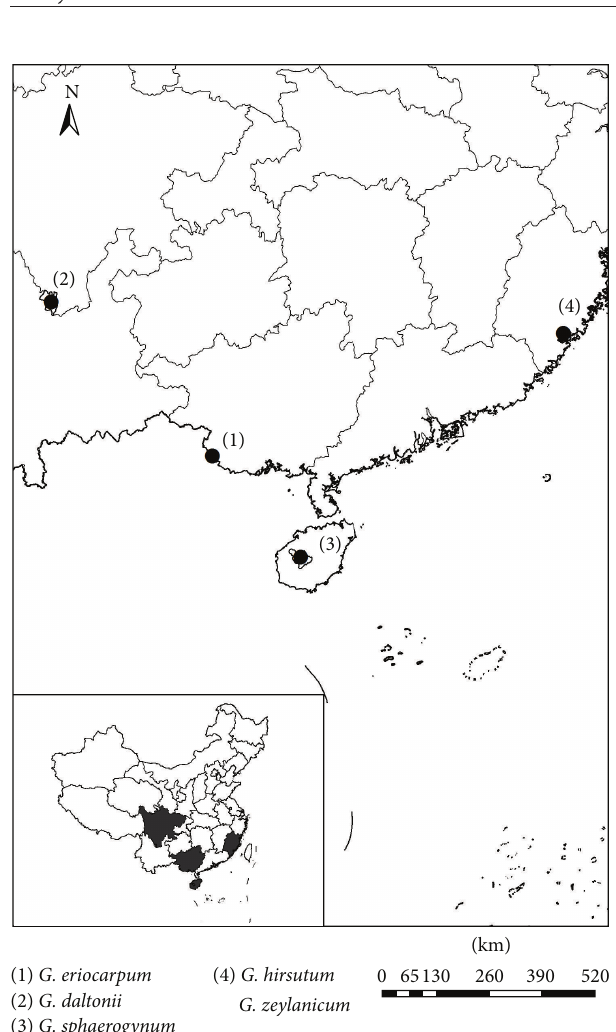
Figure 1: Study sites of five Glochidion species from south China in this